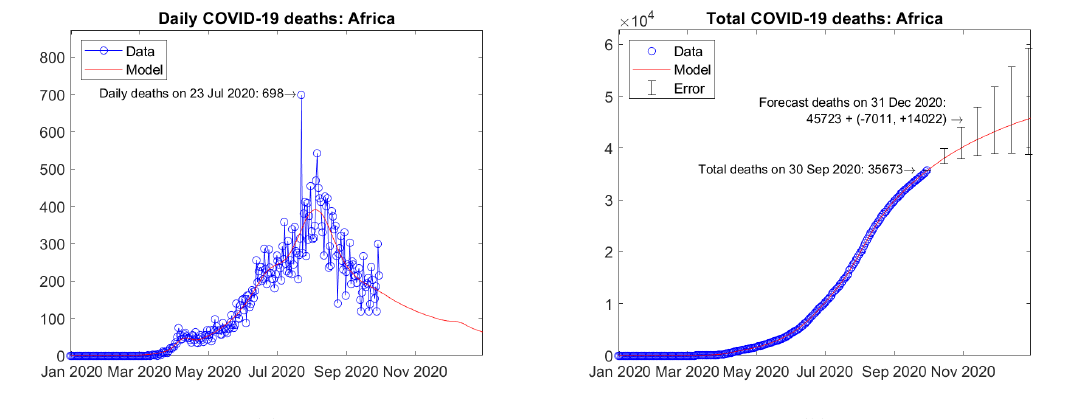
Figure 30. Actual and predicted trends in Africa: ( a ) total deaths; ( b ) daily